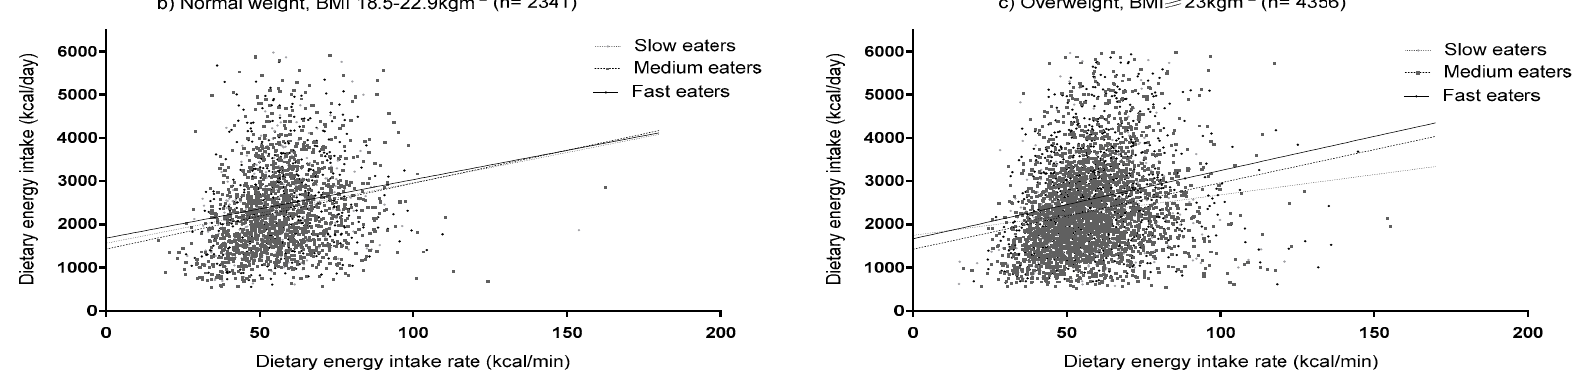
Figure 1. Simple slope analysis representing the modifying effects of self-reported eating rates (SRER) on the association between dietary energy intake rate (EIR) and daily dietary energy intake, among ( a ) total population, and individuals who were ( b ) normal-weight and ( c ) overweight. The three SRER groups represent the rates of eating, i.e., slow, medium and fast.